Question: Provide a publication-style caption for this figure.
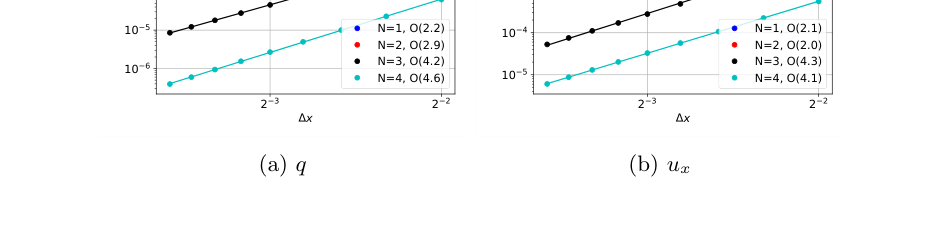
Answer: L-2 error norms for the linear diffusion equation. Note that q converges at O(N+1), while ⃗u has an odd-even oscillation between O(N+1) and O(N) convergence rates. uy and uz have near identical plots to ux and are omitted for brevity.